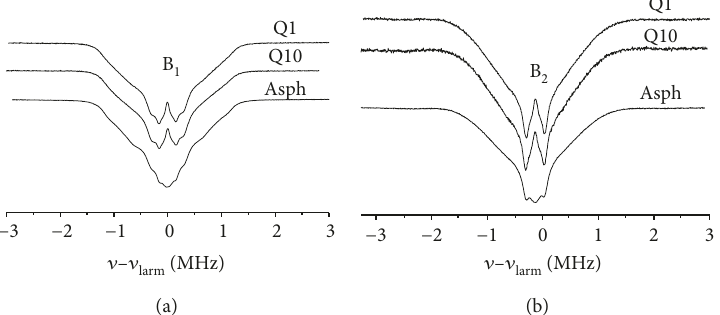
Figure 7: Mims ENDOR near the proton Larmor frequency measured for asphaltenes and adsorbed samples Q1 and Q10 at (a) B 3395 3mT and (b) B = 3448 9 mT . T = 20 K , W-band. 2